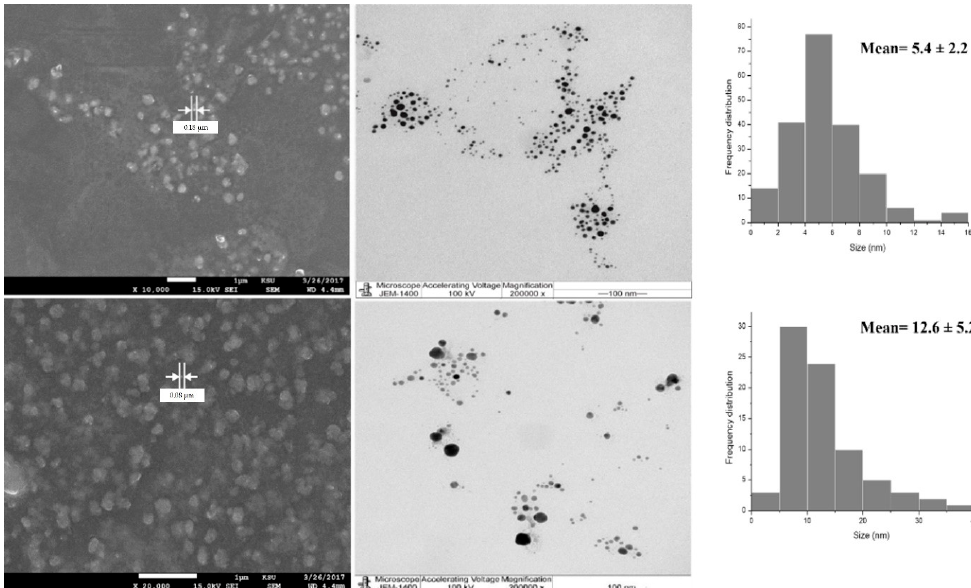
Figure 3. SEM image ( left side ) and the corresponding TEM image ( right side ) of AgNPs capped with the biomolecules from O. forsskalii . Scale bar represents 1 μ m and 100 nm and magnification of 10,000, 20,000 and 200,000 for SEM and TEM images, respectively. Size measurements were analyzed by ImageJ software constructed from TEM micrographs.